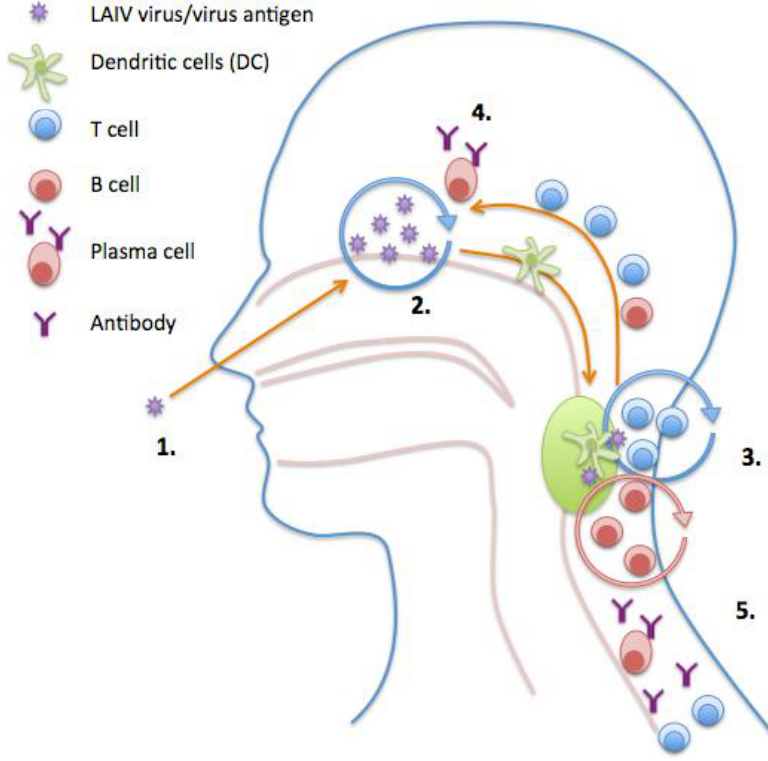
Figure 3. Model of induction of immune responses after live attenuated influenza vaccination (LAIV). ( 1 ) Intranasal LAIV immunization; ( 2 ) Viral antigen is transported to the tonsils/adenoids by the Dendritic Cells (DCs); ( 3 ) Activation and proliferation of T and B cells in tonsils/adenoids with help from CD4 + T-cells. Affinity maturation of B cells; ( 4 , 5 ) Activated T and B cells home to site of infection and enter circulation. Plasma cells secrete antibody into the blood and at the mucosal